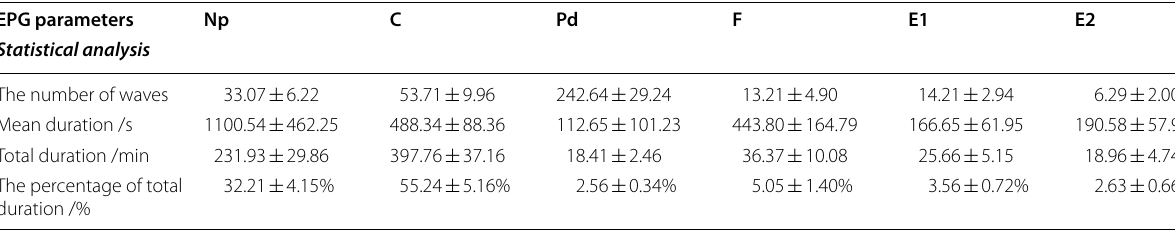
Table 1 The statistics analysis of EPG